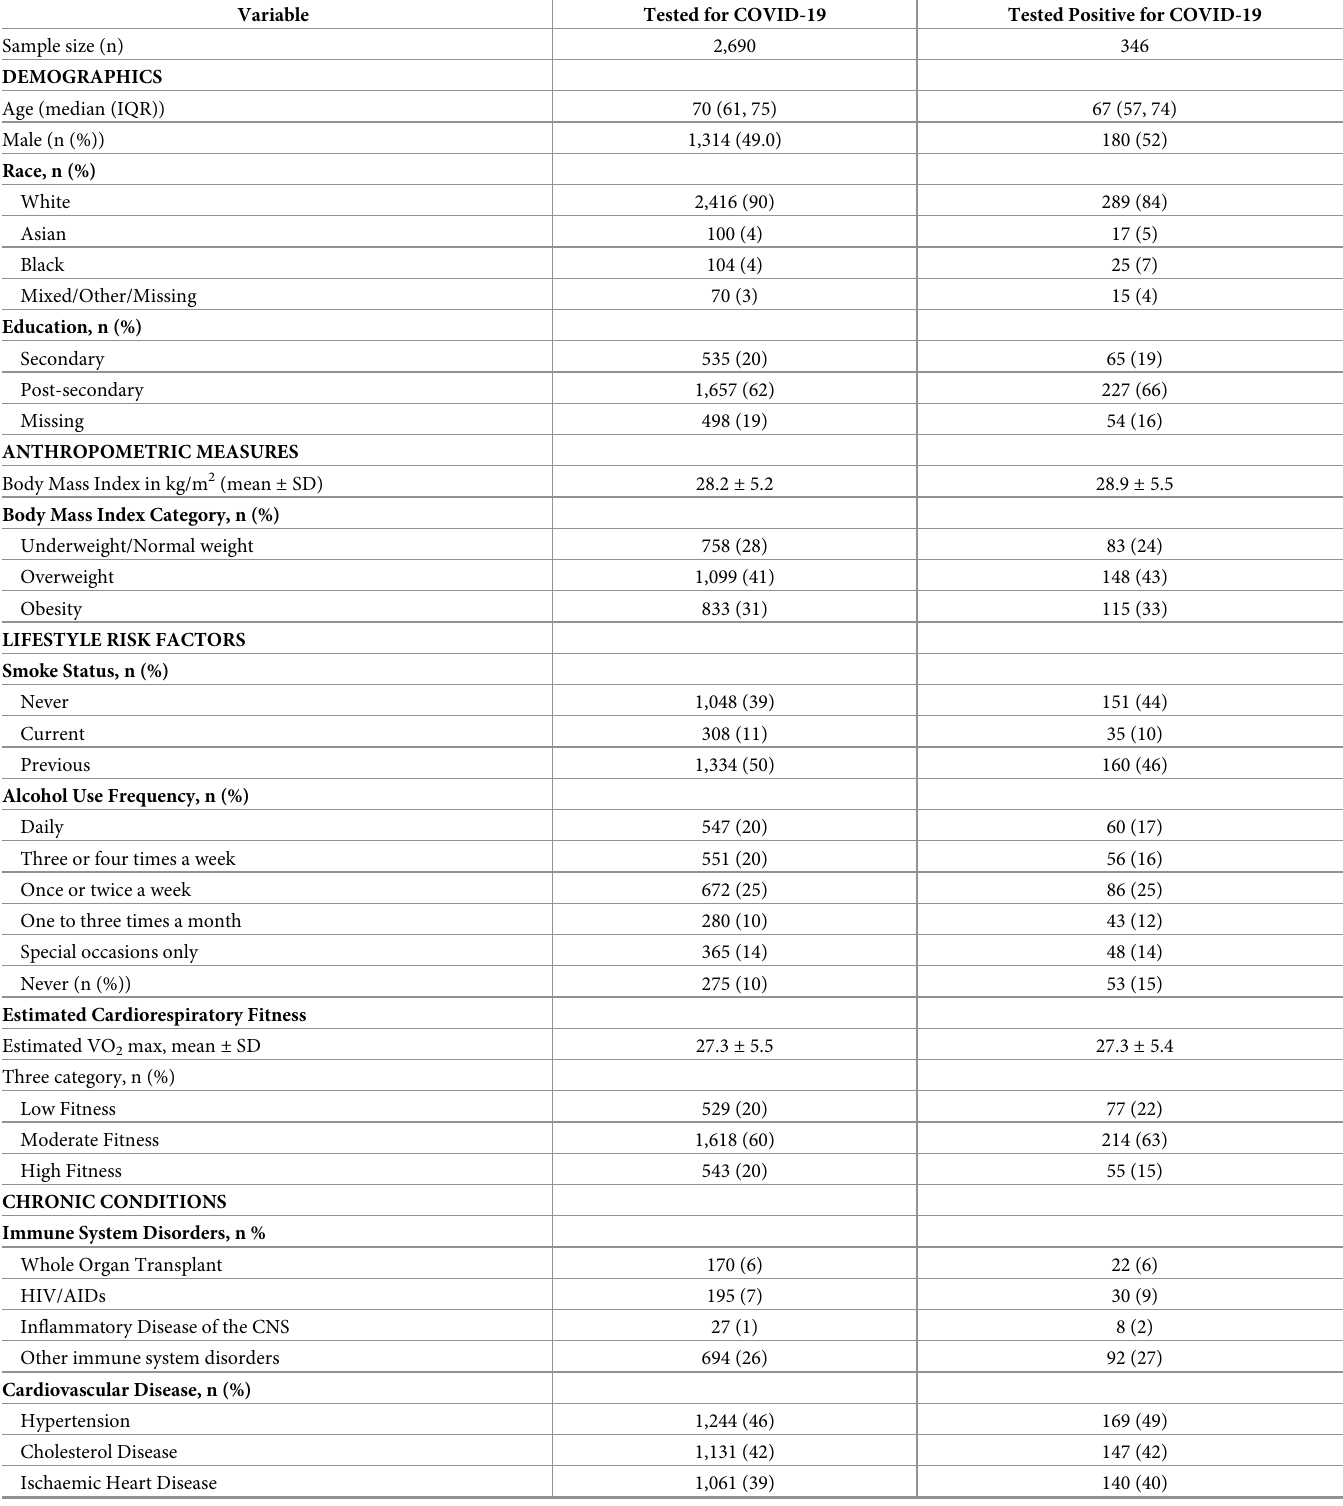
Table 1. Characteristics of the whole study population and those who tested positive for